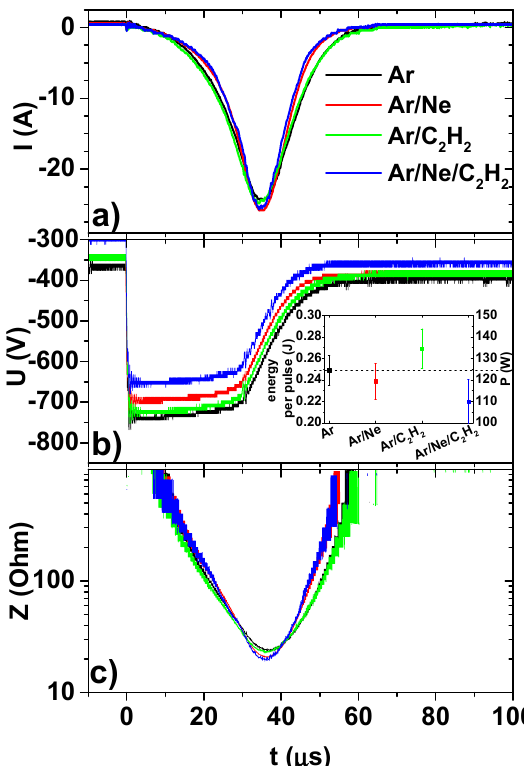
Figure 2. Typical time characteristics of current (I) ( a ), voltage (U) ( b ) and total impedance (Z) ( c ) during the pulse in different gas compositions. Average power P is in the 110 to 135 W interval, inset of ( b )